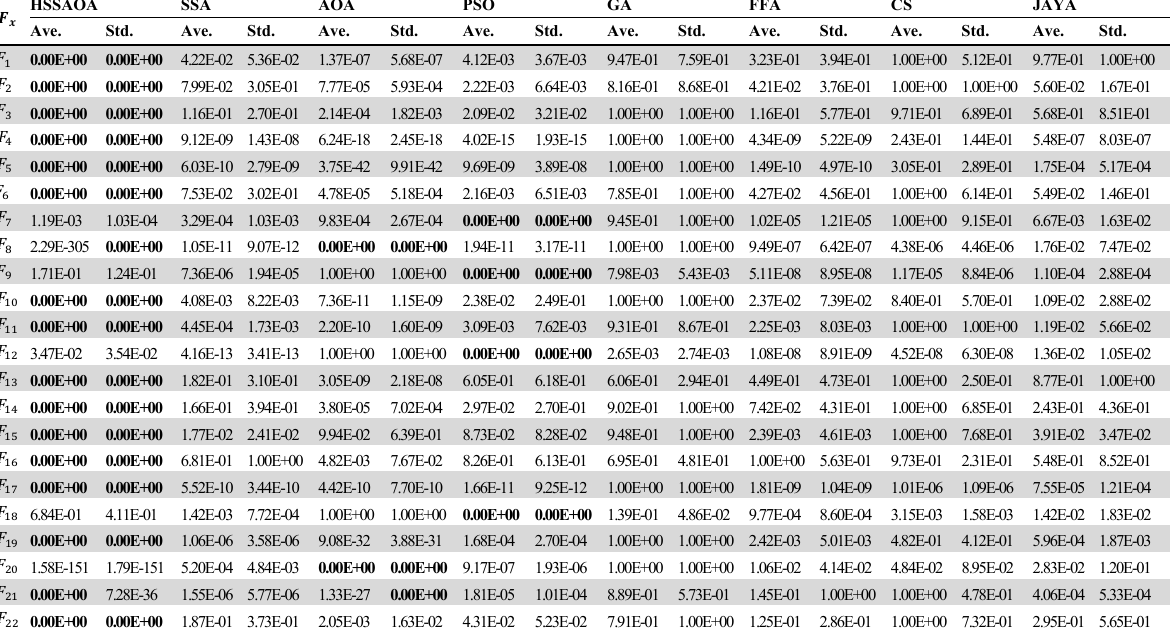
According to Table 5, statistical analysis was performed between successful algorithms and other algorithms. According to the results in Table 6, these algorithms obtained statistically significant differences compared to the algorithms they were compared. Table 7 contains the average and standard deviation results of the optimized benchmark functions according to Group 3. Normalized (0-1) average (Ave.) and standard deviation (Std.) results of optimized benchmark functions according to Group 3 HSSAOA SSA AOA PSO GA FFA CS JAYA 𝑭 𝒙 Ave. Std. Ave. Std. Ave. Std. Ave. Std. Ave. Std. Ave. Std. Ave. Std. Ave.